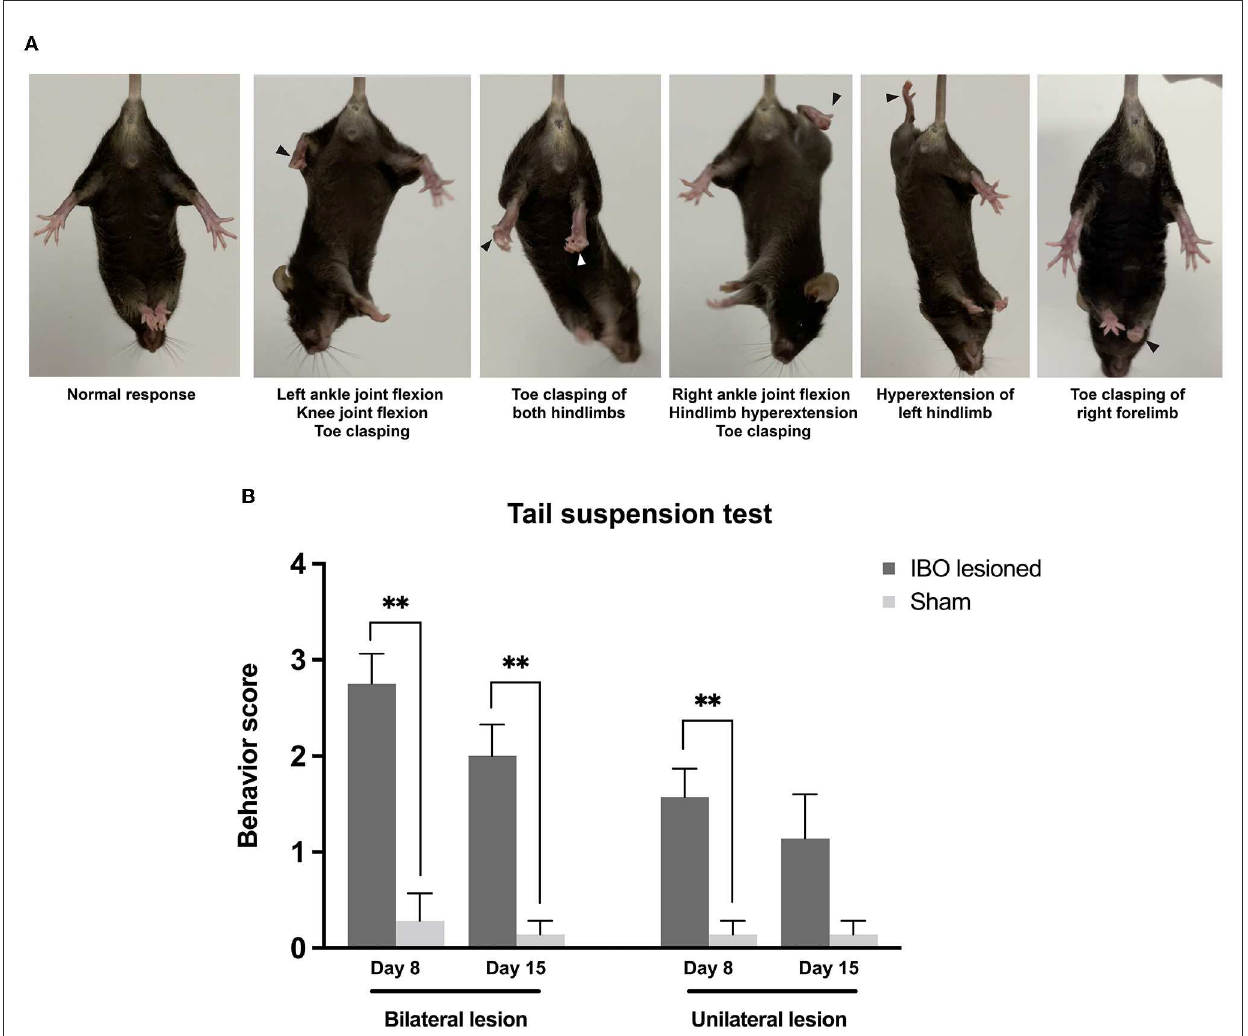
FIGURE4 Dystonia-like behaviors following bilateral and unilateral PPTg IBO lesion. (A) Photographs of representative dystonia-like behaviors in mice following a bilateral and unilateral PPTg IBO lesion. Arrows indicated abnormal behaviors. (B) Dystonia score of the tail suspension test in mice that underwent a PPTg IBO lesion. Both the bilaterally and unilaterally PPTg IBO lesioned mice had higher dystonia scores after the lesion on day 8, and a significant difference persisted in the bilaterally lesioned group on day 15. * P < 0.05, ** P < 0.01, *** P < 0.001.